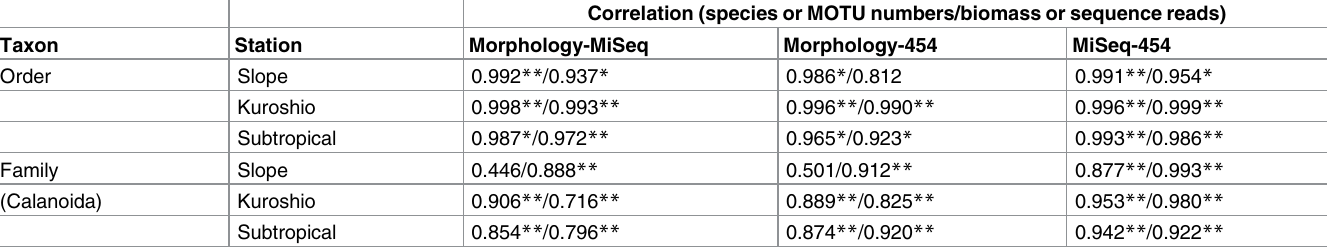
Table 4. Pearson correlation coefficients between different methods of morphological and metagenetic analyses. Correlation (species or MOTU numbers/biomass or sequence